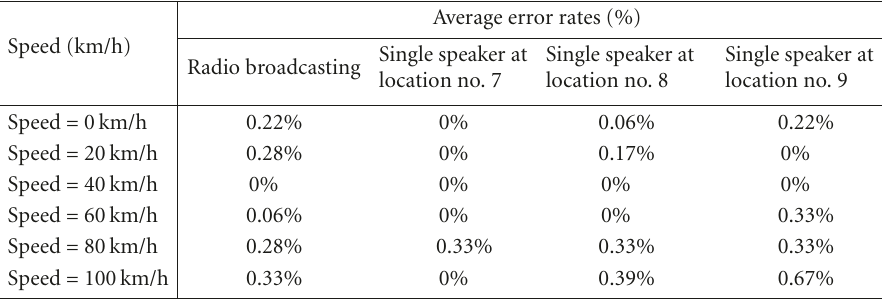
Table 5: Average error rates of unmodeled locations at various